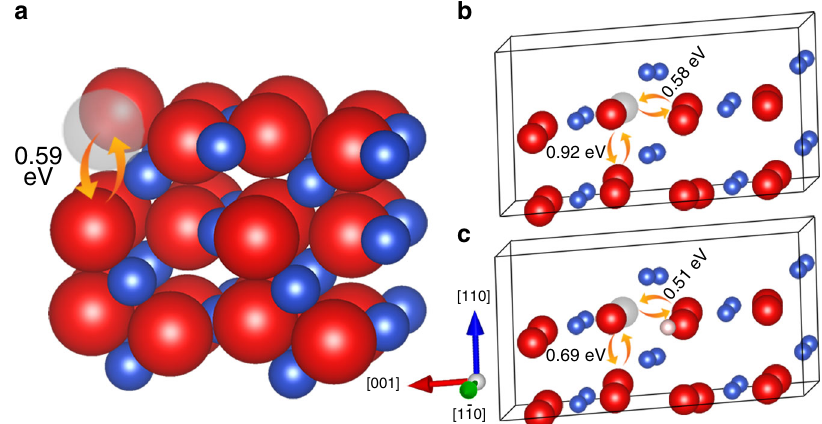
Fig. 7 Calculations of energy barriers for atom-vacancy exchanges in CuO. a Energy barrier for the exchange of a surface oxygen vacancy with the subsurface oxygen. b , c Intralayer and interlayer oxygen-vacancy diffusion barriers with and without the presence of interstitial H, respectively. Blue, red, pink, and gray balls represent Cu, O, H, and O vacancy,